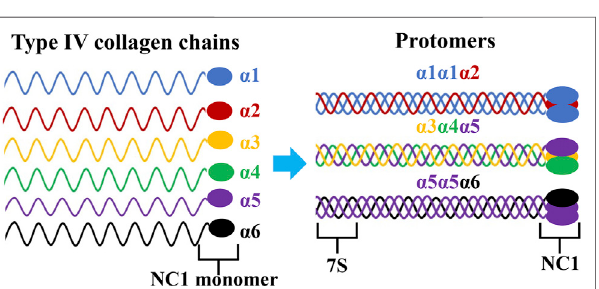
FIGURE 4 | Triple helical organization of the type IV collagen family. Six genetically different type IV collagen α -chains ( α 1- α 6) are arranged into three triple helical protomers that differ in their chain composition. All promoters contain a 7S triple helical domain at the N-terminal that is rich in cysteine and lysine residues, a central collagenous triple helix domain, and a non- collagenous (NC1) trimer at the C- terminal.